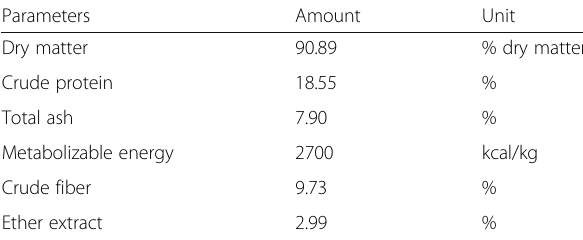
Table 1 Chemical and nutritional composition of